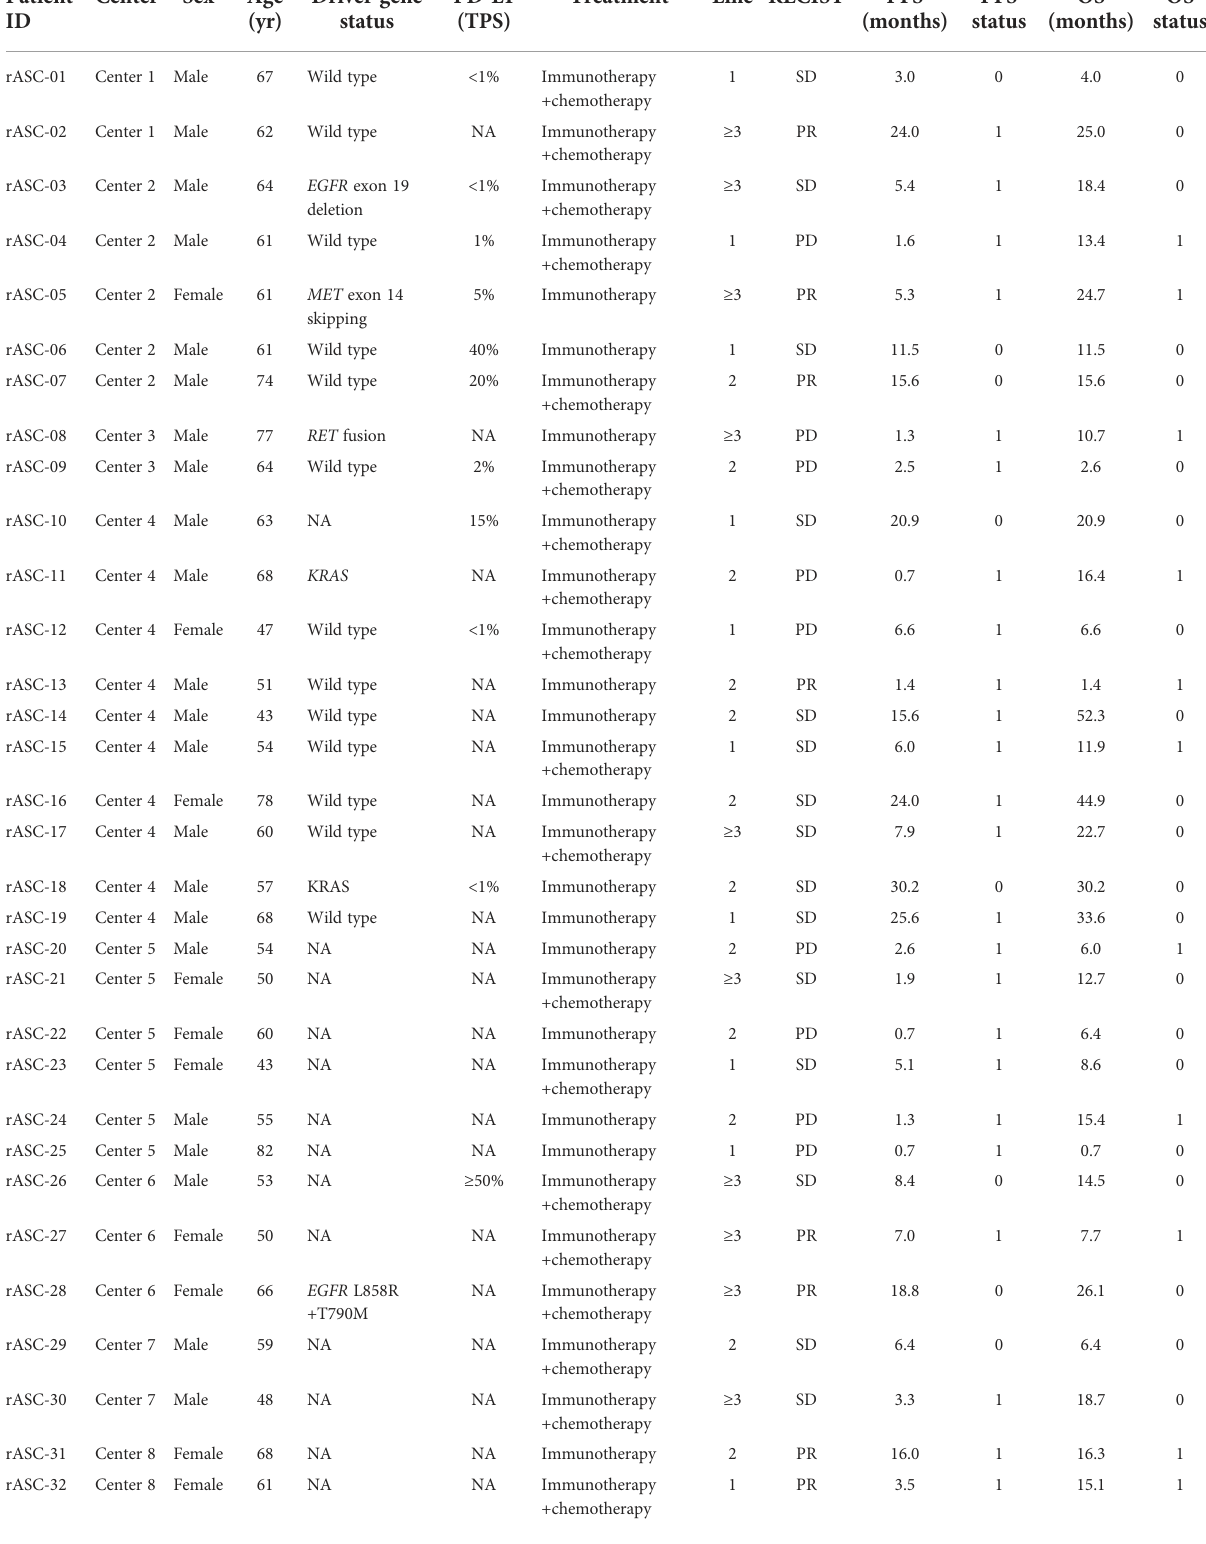
TABLE 2 Demographic and clinical information of real-world ASC